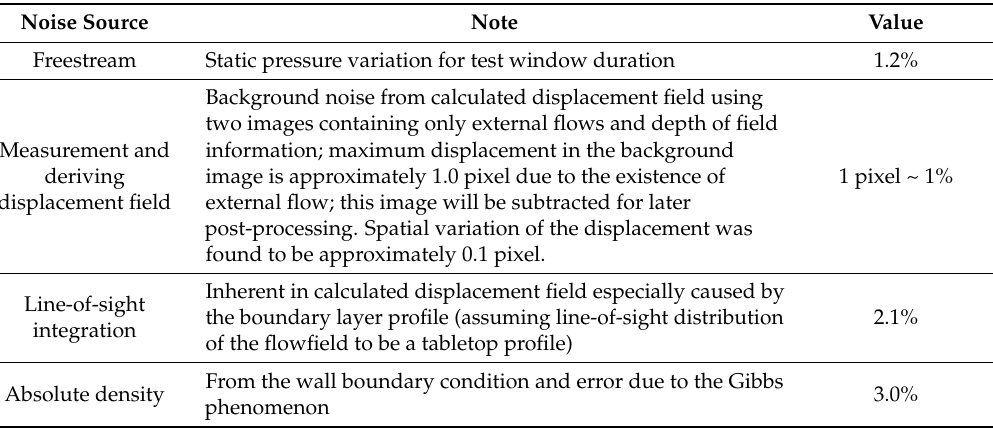
Table 2. Summary of uncertainty